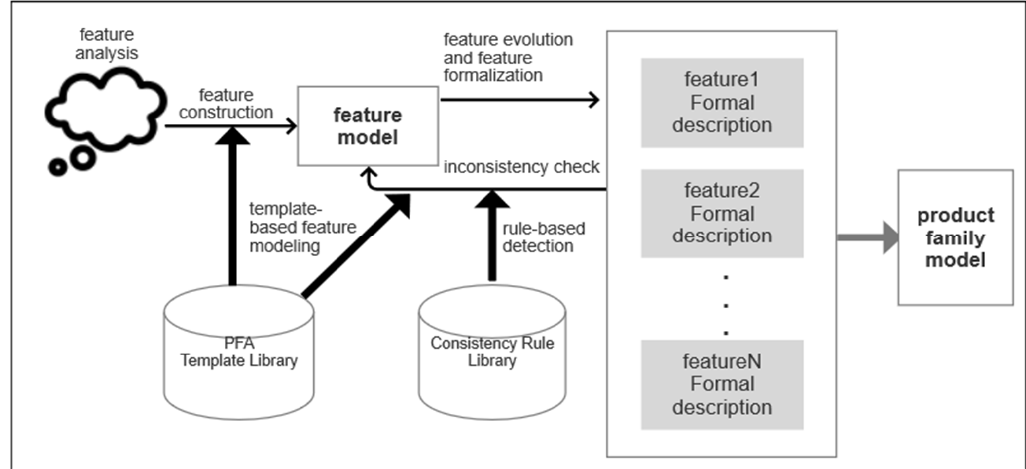
Figure 1. Computer-aided formalization framework for product family model.